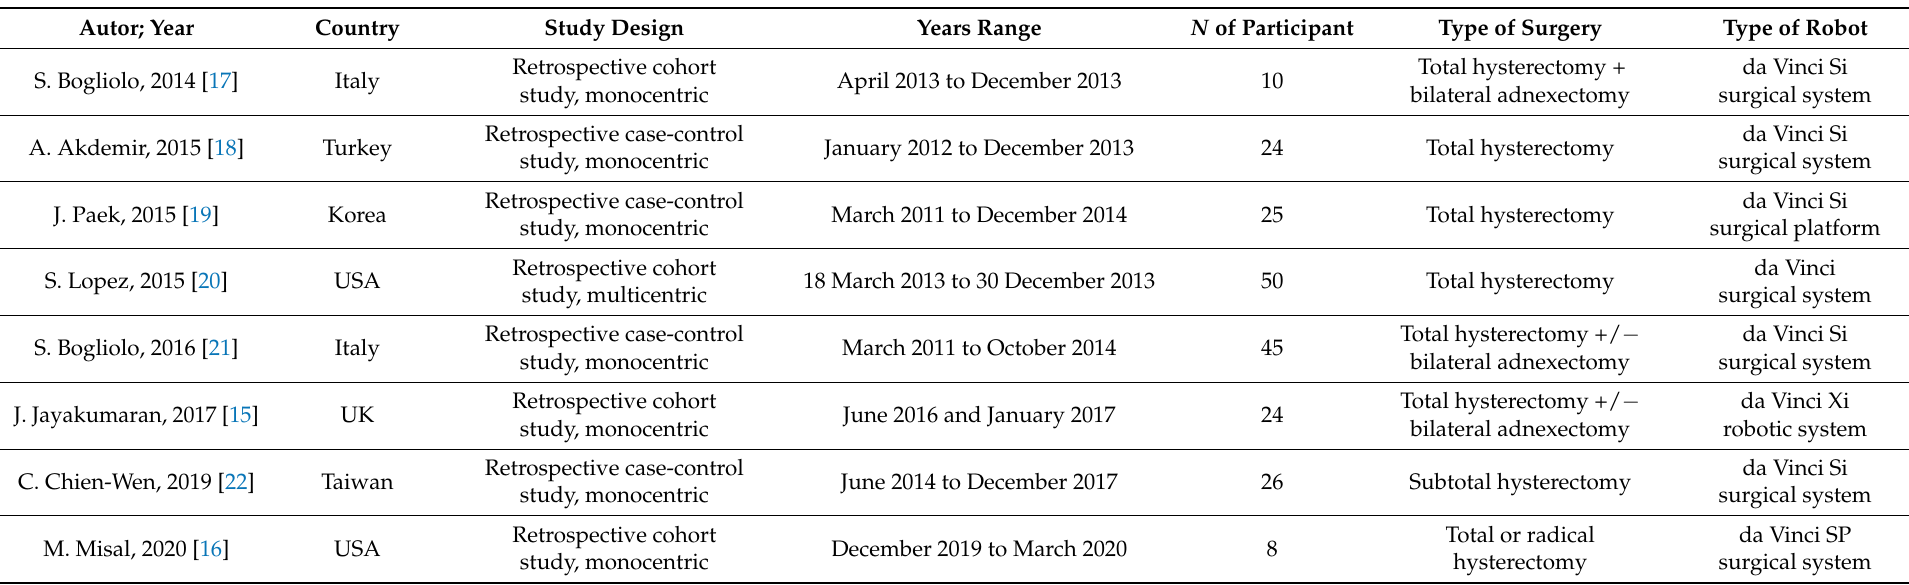
Table 1. Studies’